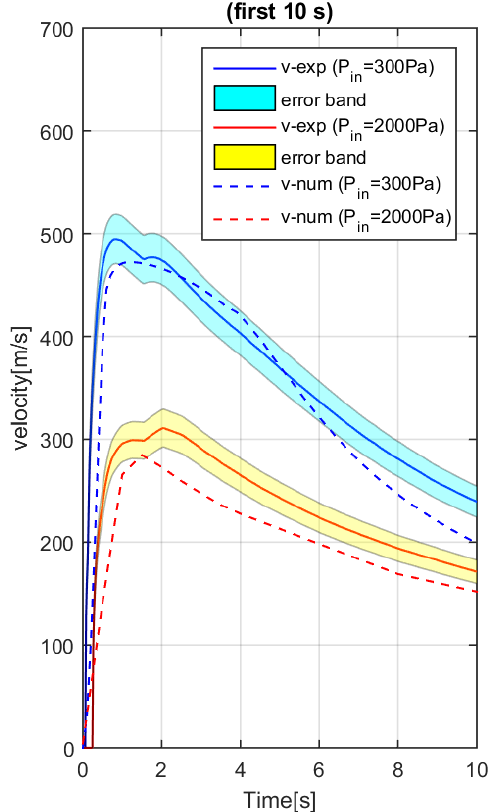
Figure 23. Comparing numerical “numb” and experimental “exp” results for flow rate 27 L/min, valve C, transducers under C, for two different initial vacuum levels “Pin” (300 Pa and 2000 Pa). Table 6. Mach number peak of experimental results and Mach number peak of numerical result, during a simulation of 27 L/min flow rate, air from Valve F. Data from Mach Number Peak Numerical simulation 0.55 Experimental campaign